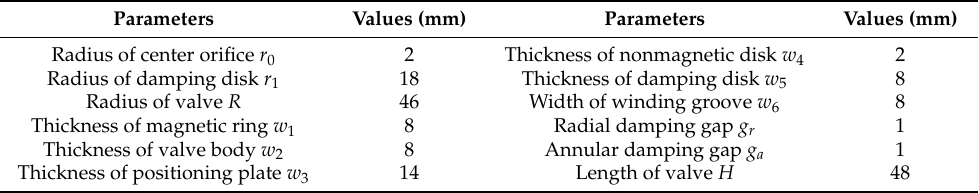
Table 1. Primary structural dimension of the initial MR valve.